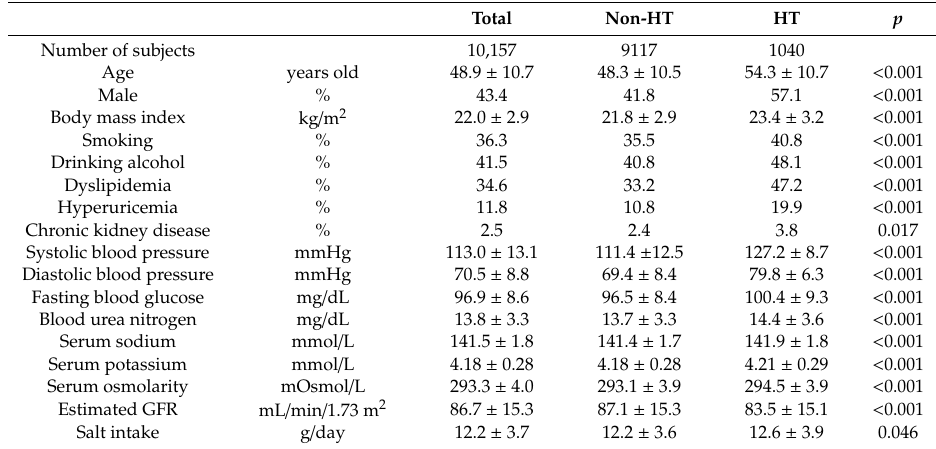
Table 1. Baseline demographic data on the study subjects and the di ff erence of baseline data between the developing hypertension (HT) group and non-hypertension (non-HT)